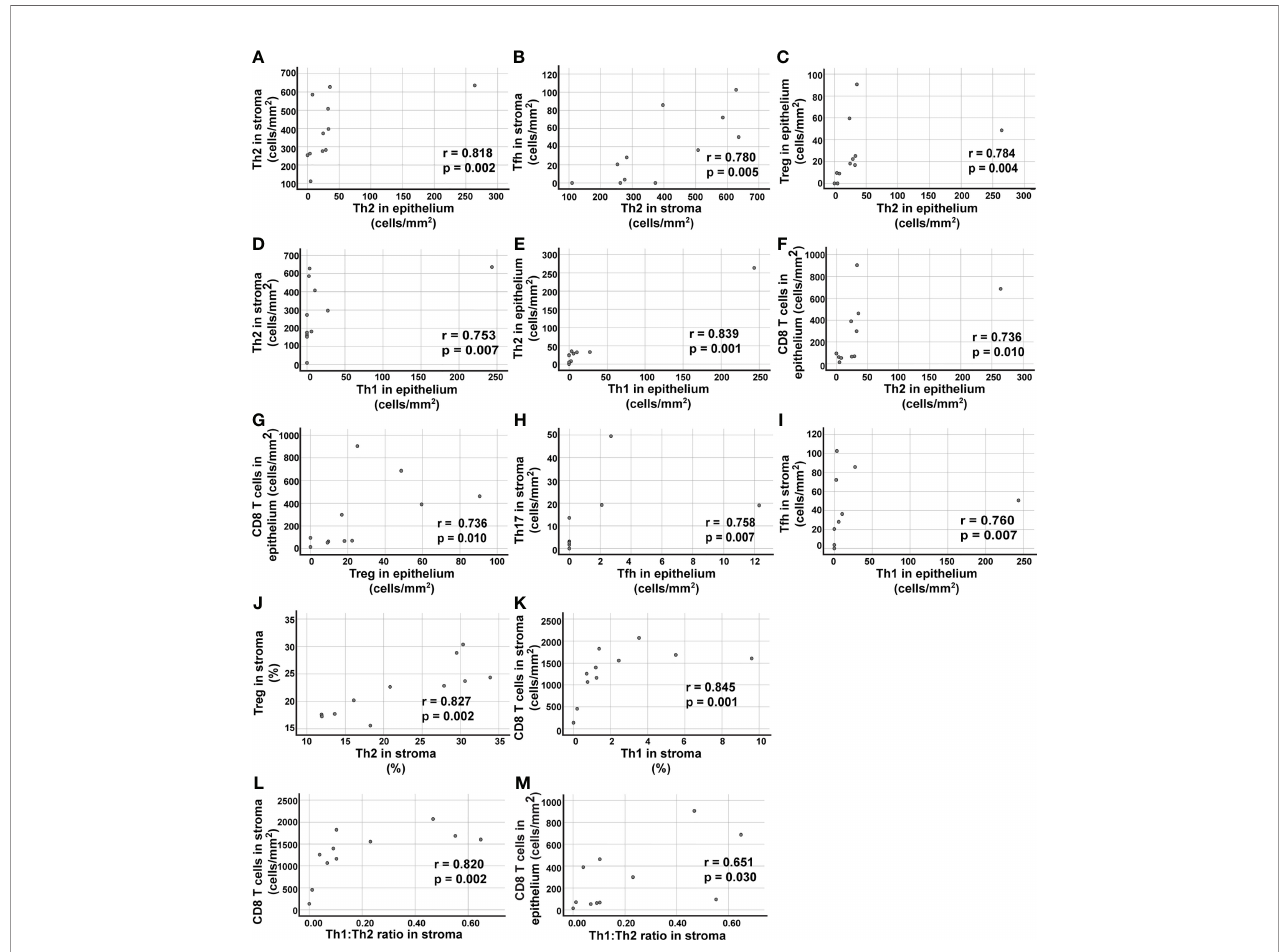
FIGURE 8 | Correlation analysis of T cell data in tumor epithelium and tumor stroma. Spearman´s rho was used to analyze the data presented in Figure 3 and identify correlations. (A – I) Nine of the tested combinations of T cell density data (cells/mm 2 ) resulted in p values ≤ 0.01 and positive correlation r>0.7. For a complete list of analyzed combinations, see Supplementary Table 2 . (J, K) Two combinations of T cell subsets showed positive correlation with p ≤ 0.01 and r>0.7 when percent numbers for the Th cell subsets were used in the correlation analysis (for a complete list of analyzed combinations, see Supplementary Table 3 ). (L) The ratio of Th1:Th2 cells in stroma showed a positive correlation with the density (cells/mm 2 ) of CD8 + T cells in tumor stroma, and (M) in tumor epithelium. The Th2 data included in the correlation analysis was from the immunostainings using the anti-GATA-3 clone L50-816. Each symbol represents data from one NSCLC